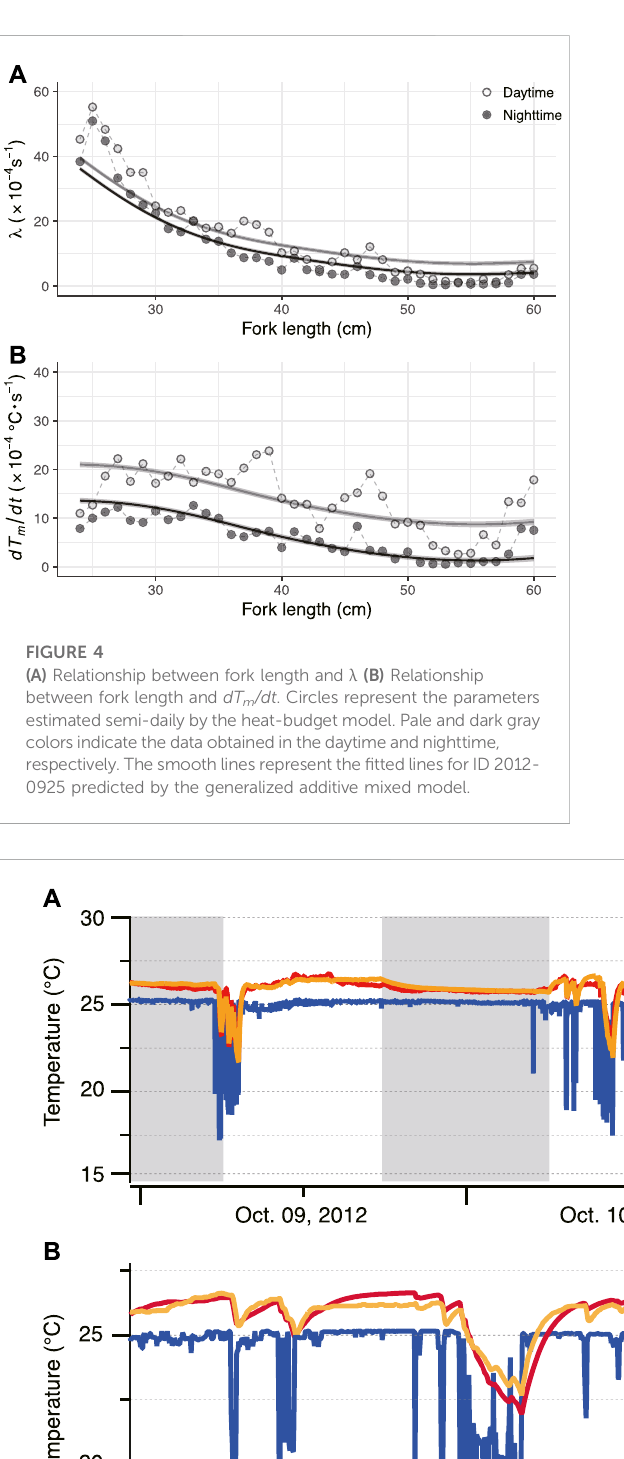
FIGURE 5 Time-series of the ambient temperature (blue) and body temperature (actual: red, predicted: orange) for ID 2012-0925 (A) and the enlarged data (B) .